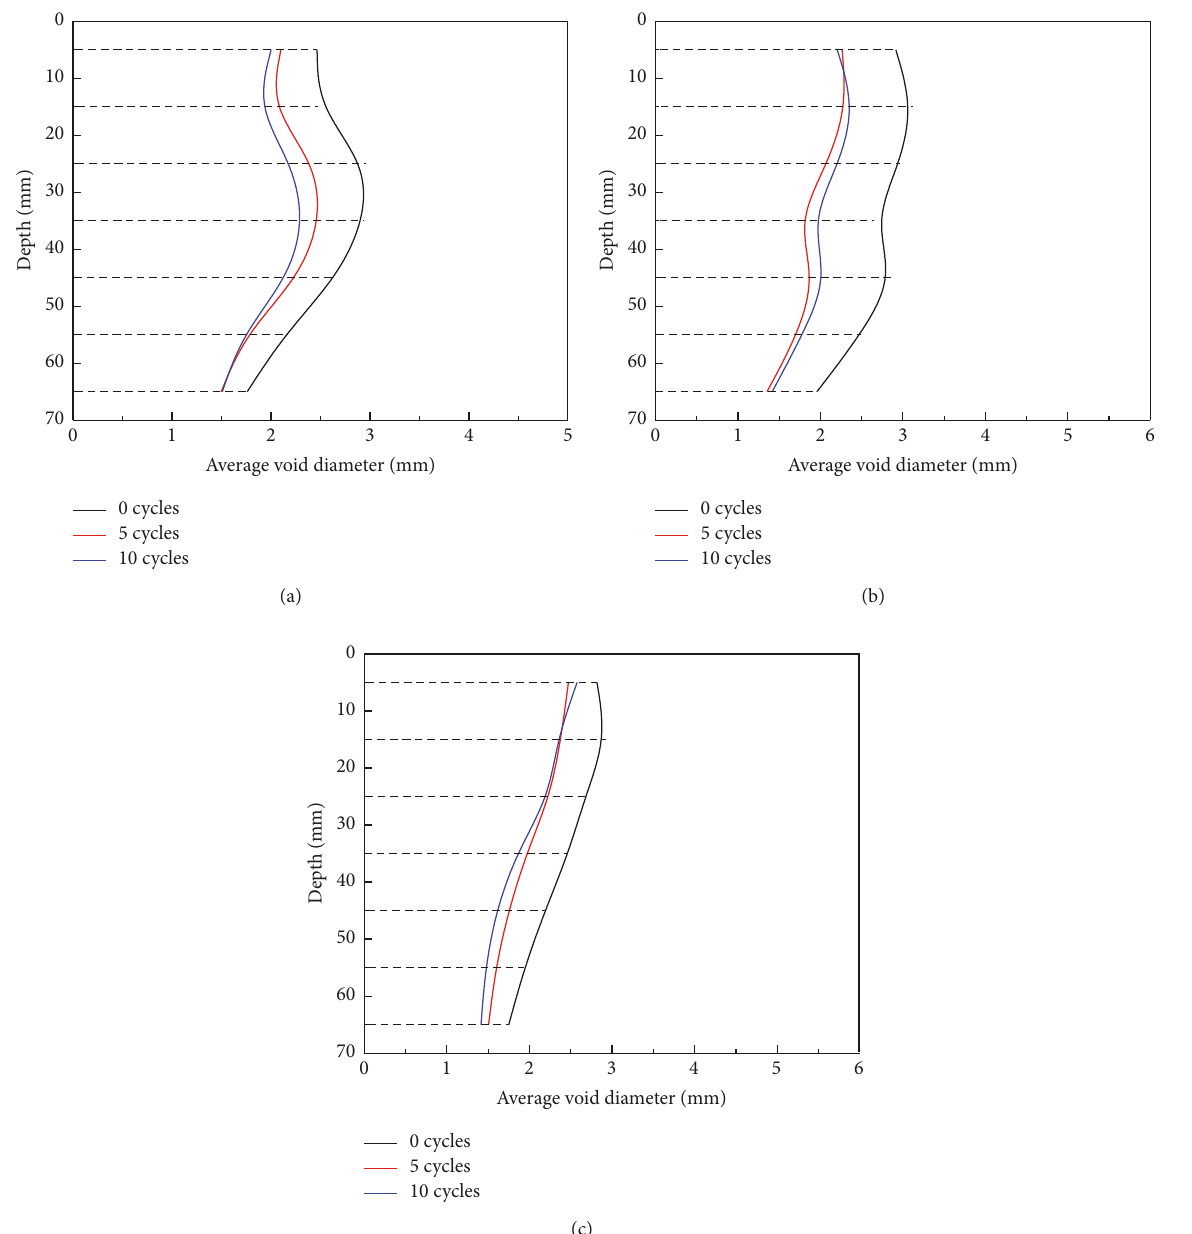
Figure 12: Average void diameter distributions of the different samples after 28 d of curing: (a) cement content = 4.0%; (b) cement content = 4.5%; (c) cement content =